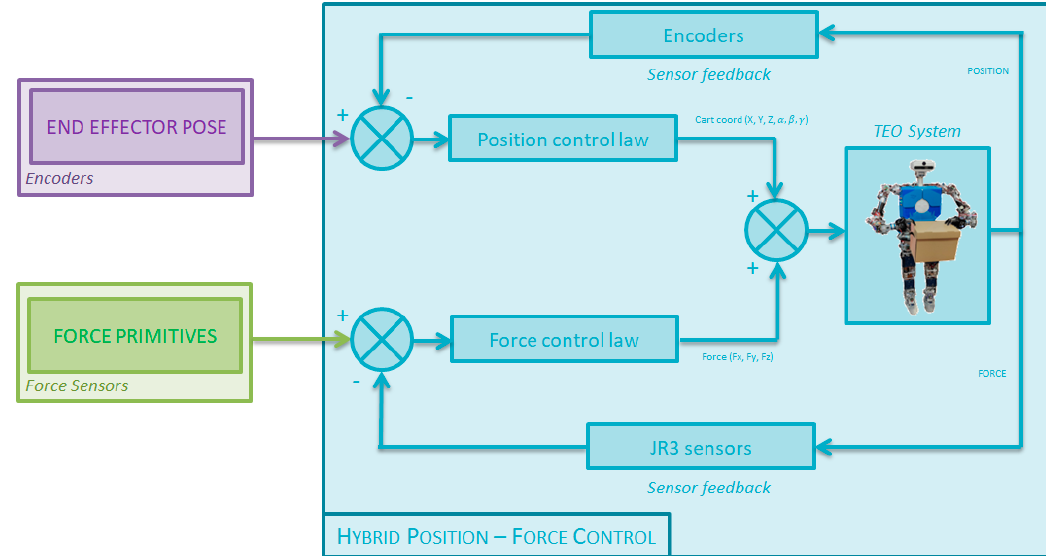
Figure 19. Hybrid position–force control for each primitive task.